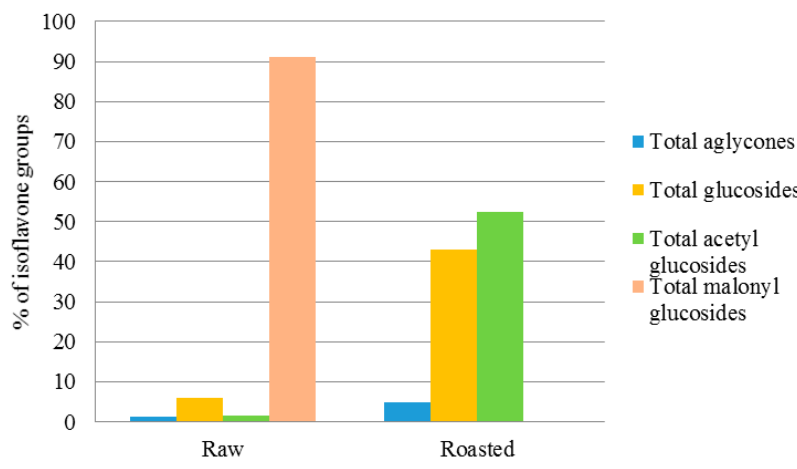
Figure 5. Comparison of four isoflavone groups in RSF and RWSF.